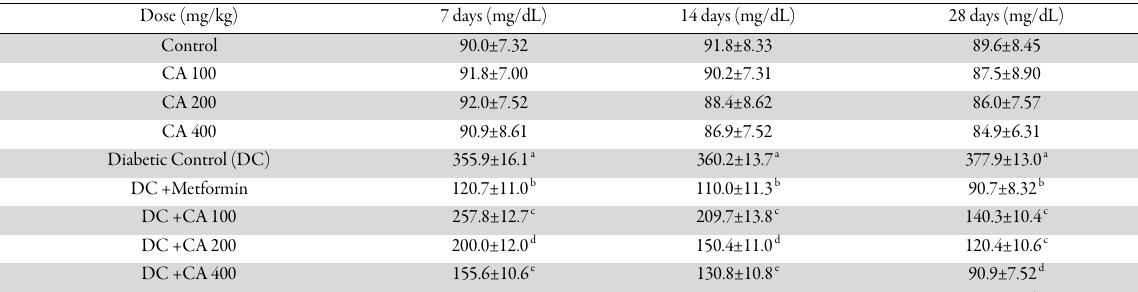
Table 6. Effect of Chrysophyllum albidum on total cholesterol level of alloxan- induced diabetic rats